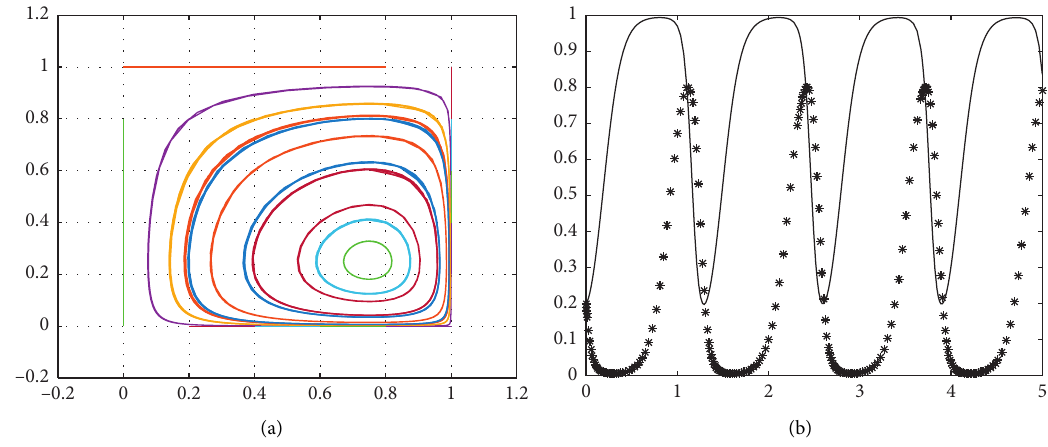
Figure 4: (a) ESS at (( 2 − k ) S − r ) /2 < P < (( 2 − k ) S − r ) /2. (b) System evolution at (( 2 − k ) S − r ) /2 < P < (( 2 − k ) S − r ) /2.